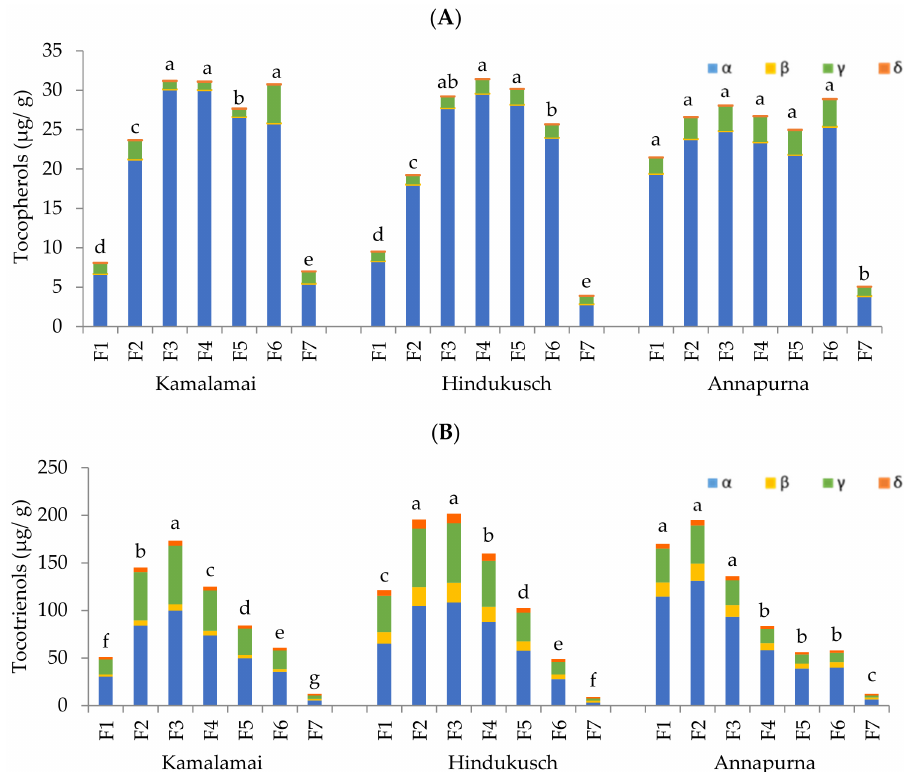
Figure 3. ( A ) α -, β -, γ -, δ - Tocopherol contents ( µ g/g), and ( B ) α -, β -, γ -, δ - Tocotrienol contents ( µ g/g) in barley pearling fractions. Results are presented as the mean; different letters indicate significant differences between pearled fractions of each genotype on log-transformed data; (Tukey- Kramer’s HSD for α =